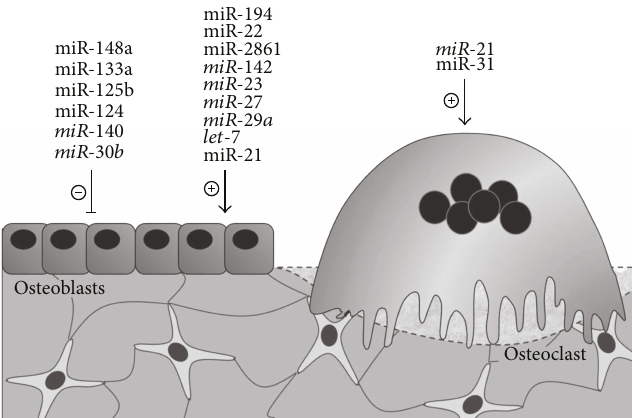
Figure 1: Circulating miRNAs di ff erentially expressed in osteoporotic patients, either upregulated (roman) or downregulated ( italic ), and their functions studied in bone